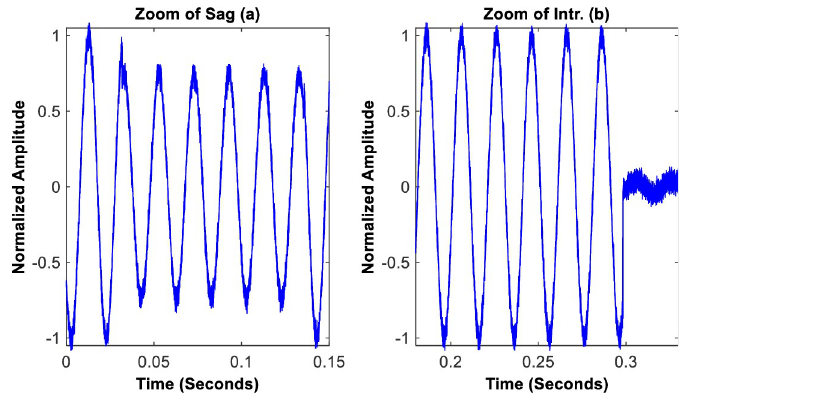
Fig 5. Zooms of instances of sag and intr.